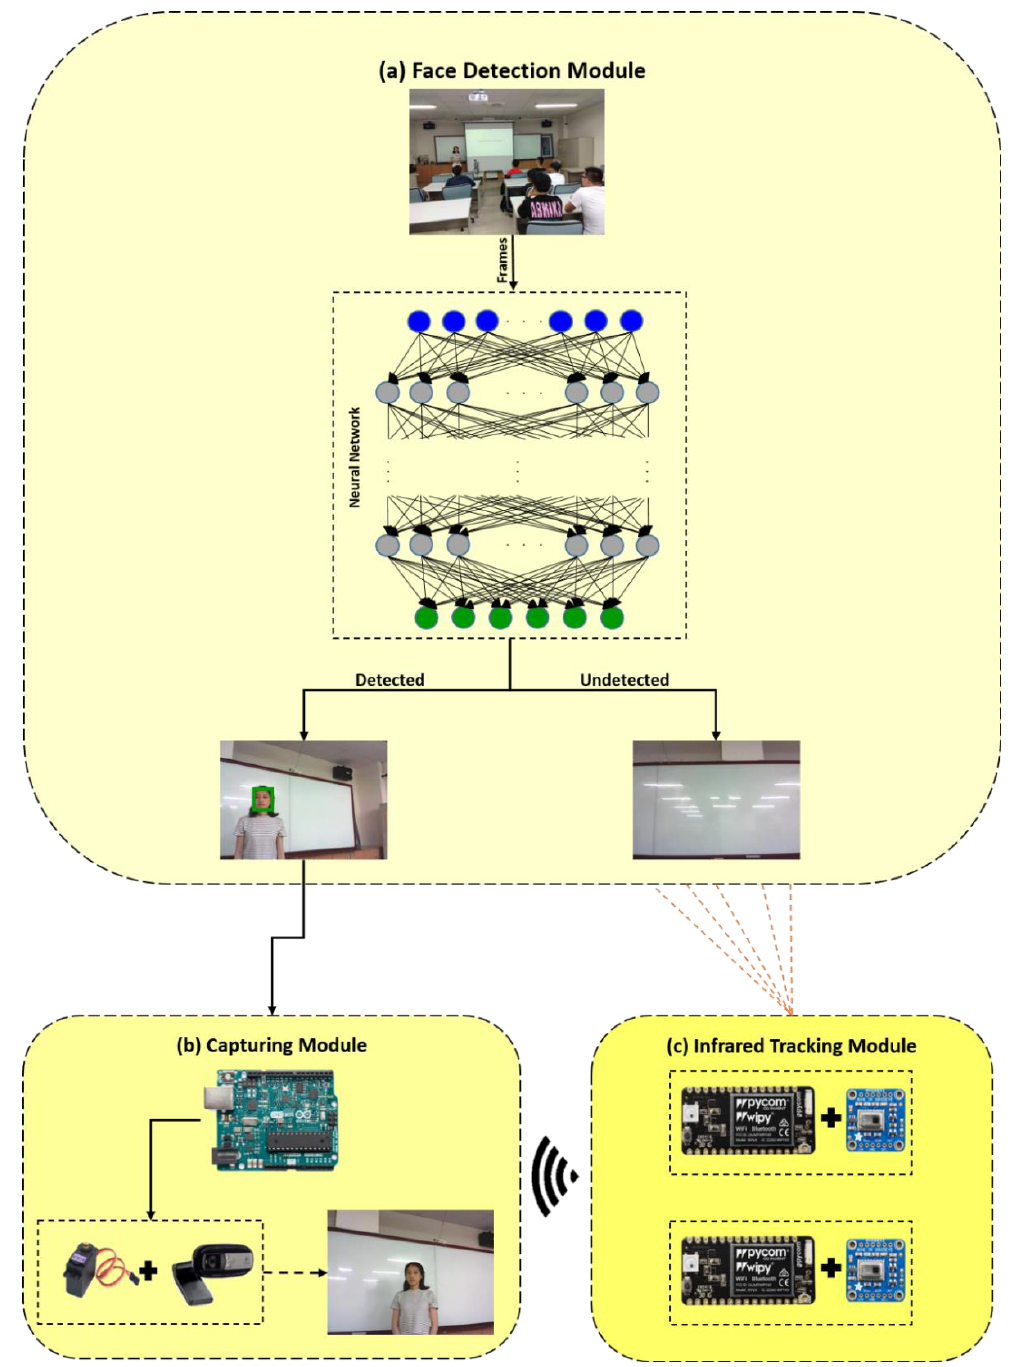
Figure 2. Framework of the intelligent lecturer tracking and capturing (ILTC) system: ( a ) face detection module; ( b ) capturing module; ( c ) infrared tracking module. module; ( b ) capturing module; ( c ) infrared tracking